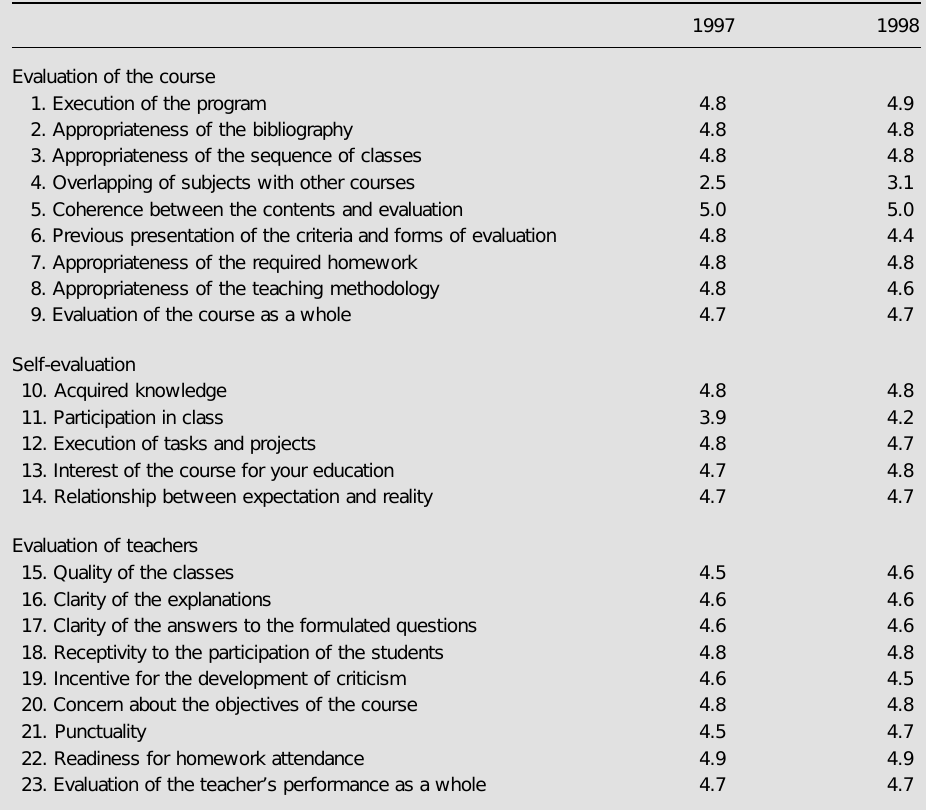
Table 3 - Evaluation of the courses “Biochemistry of Exercise” (1997) and “Biochemistry of Nutrition” (1998) given at